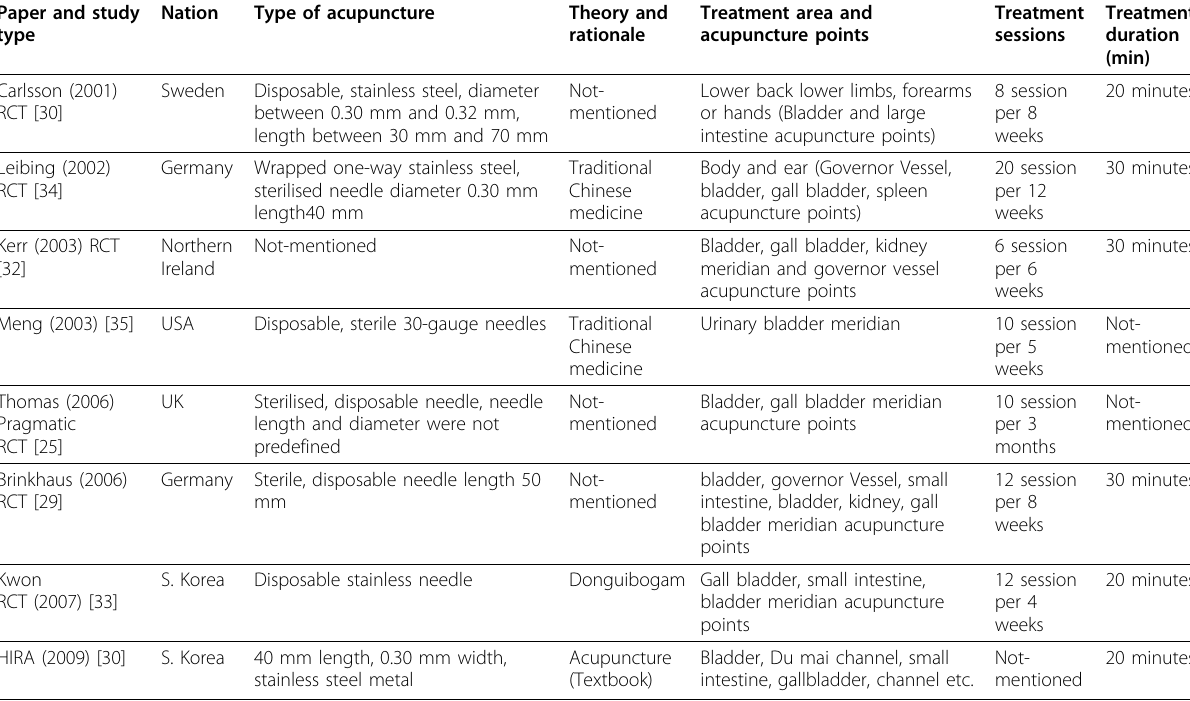
Table 2 Acupuncture protocols for chronic low back pain in the papers Paper and study